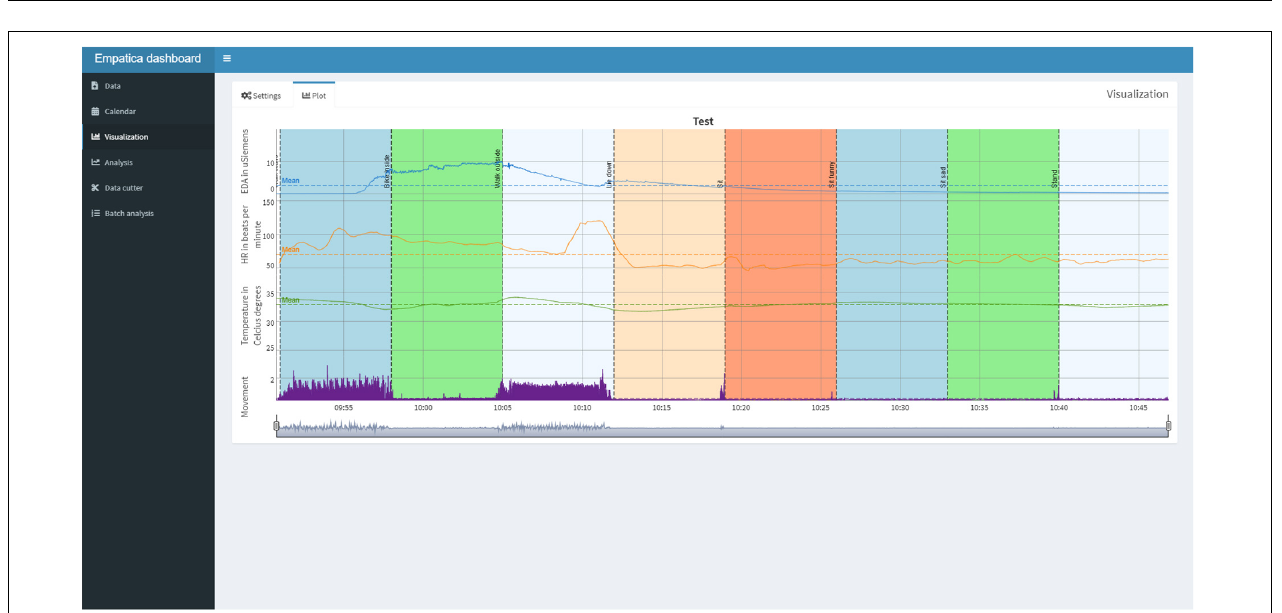
FIGURE 5 | The visualization tab has a Settings Tab that can be used to choose the settings to be displayed. Preset ranges for the physiological signal are: EDA (0–20 micro Siemens), HR (40–160 beats), temperature (24–38 ◦ C), and movement (0.98–1.25 mean acceleration).